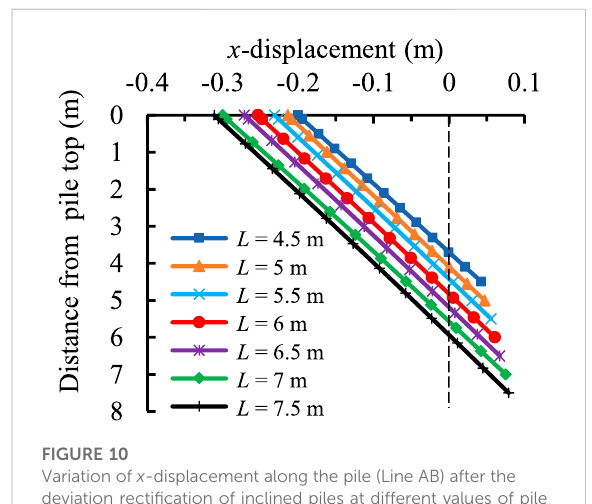
FIGURE 10 Variation of x -displacement along the pile (Line AB) after the deviation recti fi cation of inclined piles at different values of pile length L